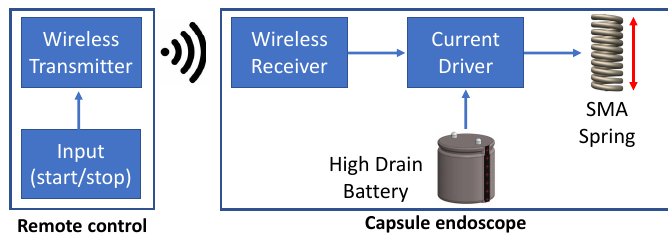
Figure 7. Actuation mechanism for capsule